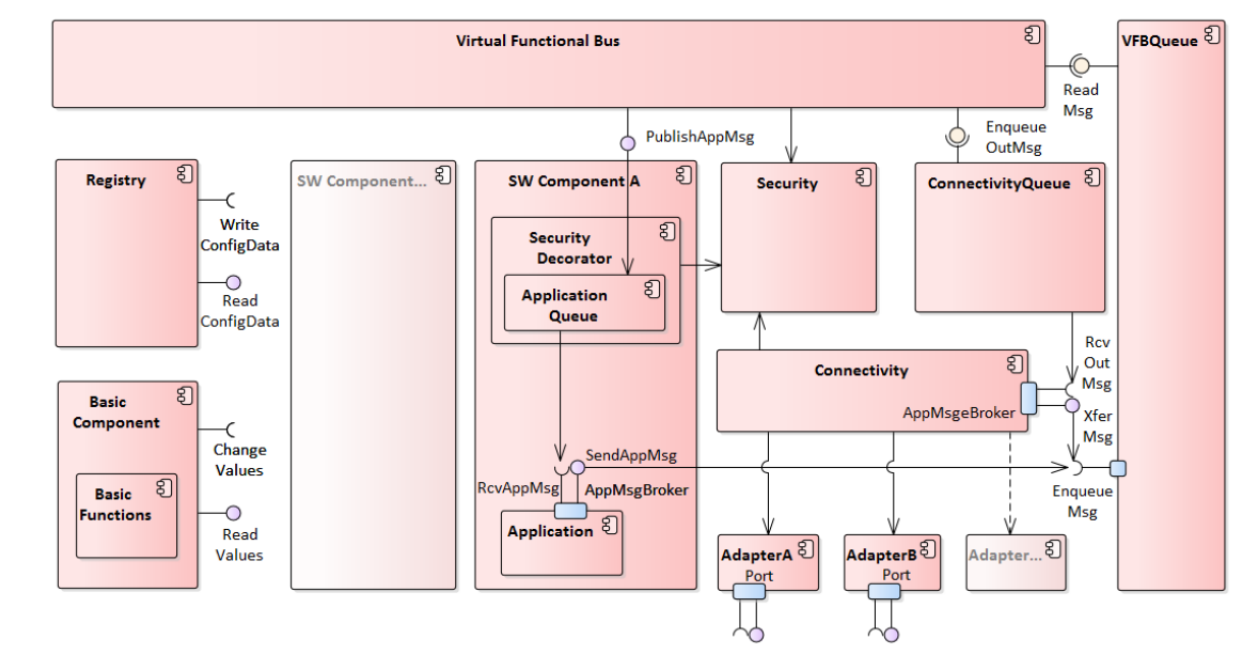
Figure 8. Platform specific implementation of the